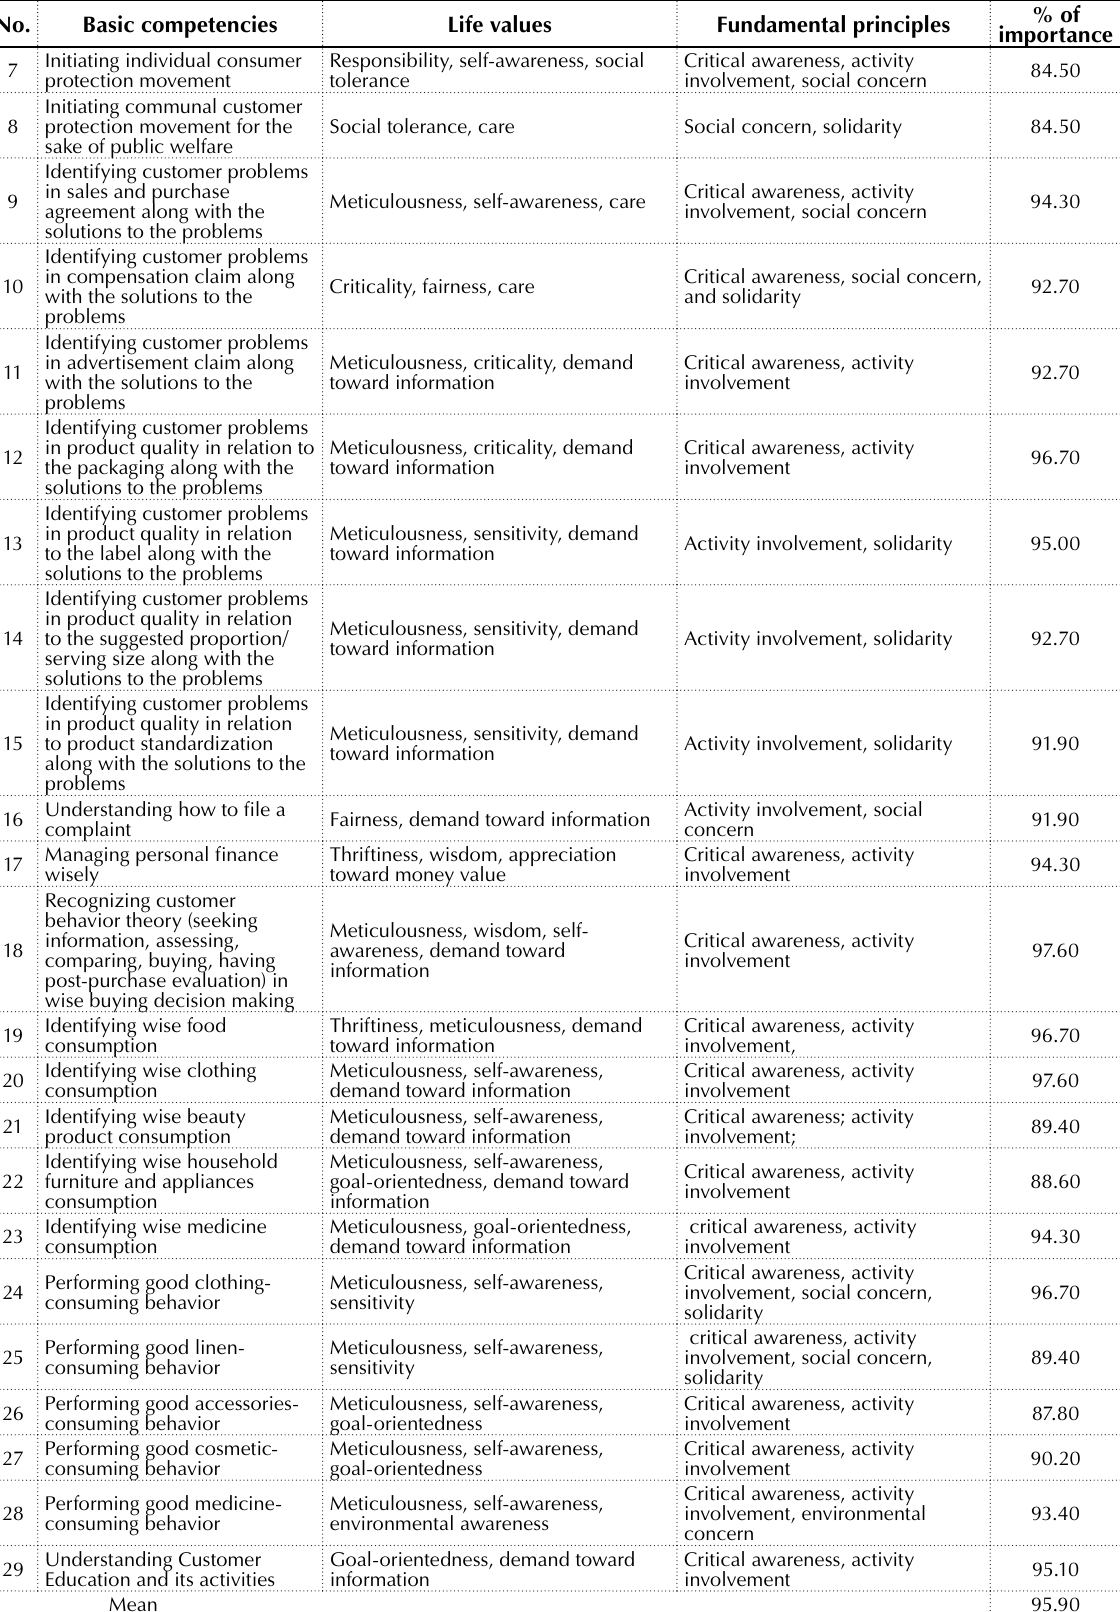
Table 3 (cont.). Mi nd map of students’ perception on the importance of Customer Education based on fundamental